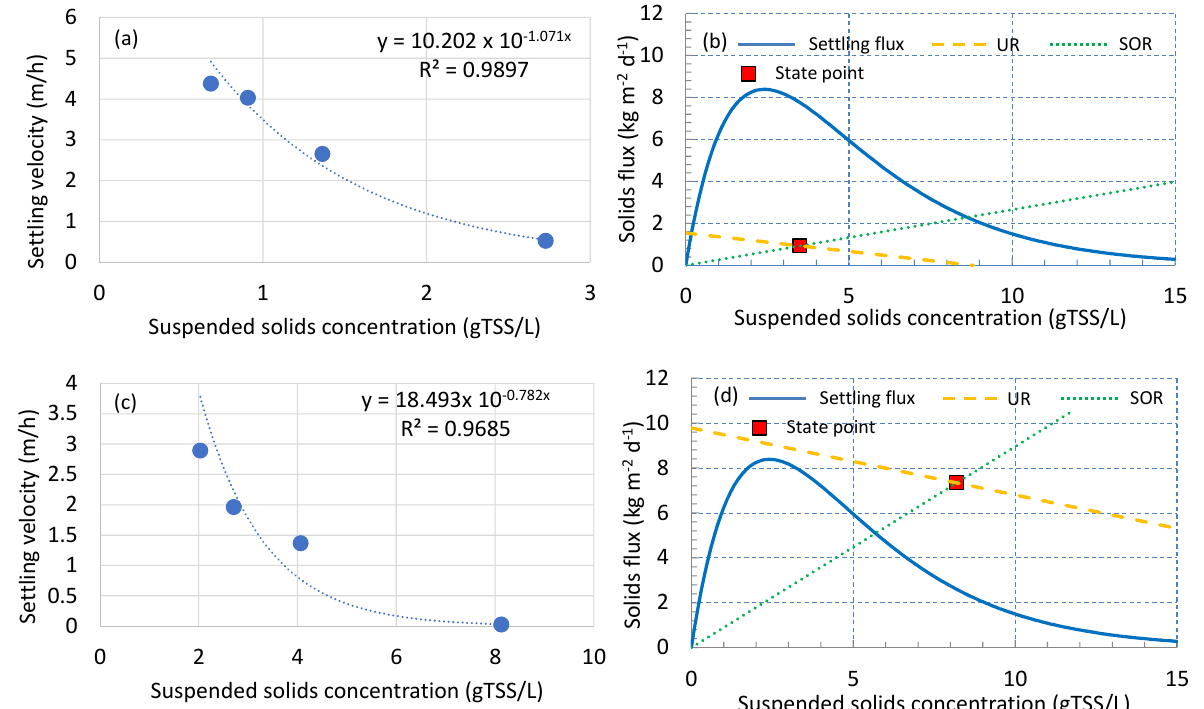
Figure 12. Settling velocity curve ( a ) and STA application results ( b ) for Corleone WWTP, and settling velocity curve ( c ) and STA application results ( d ) for Marineo WWTP.